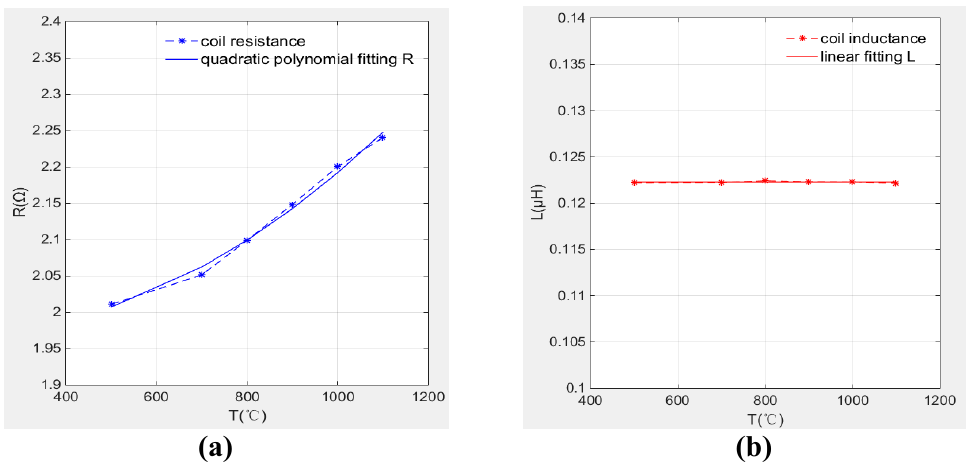
Figure 17. Coil parameters change curve with temperature; ( a ) resistance; ( b ) inductance.